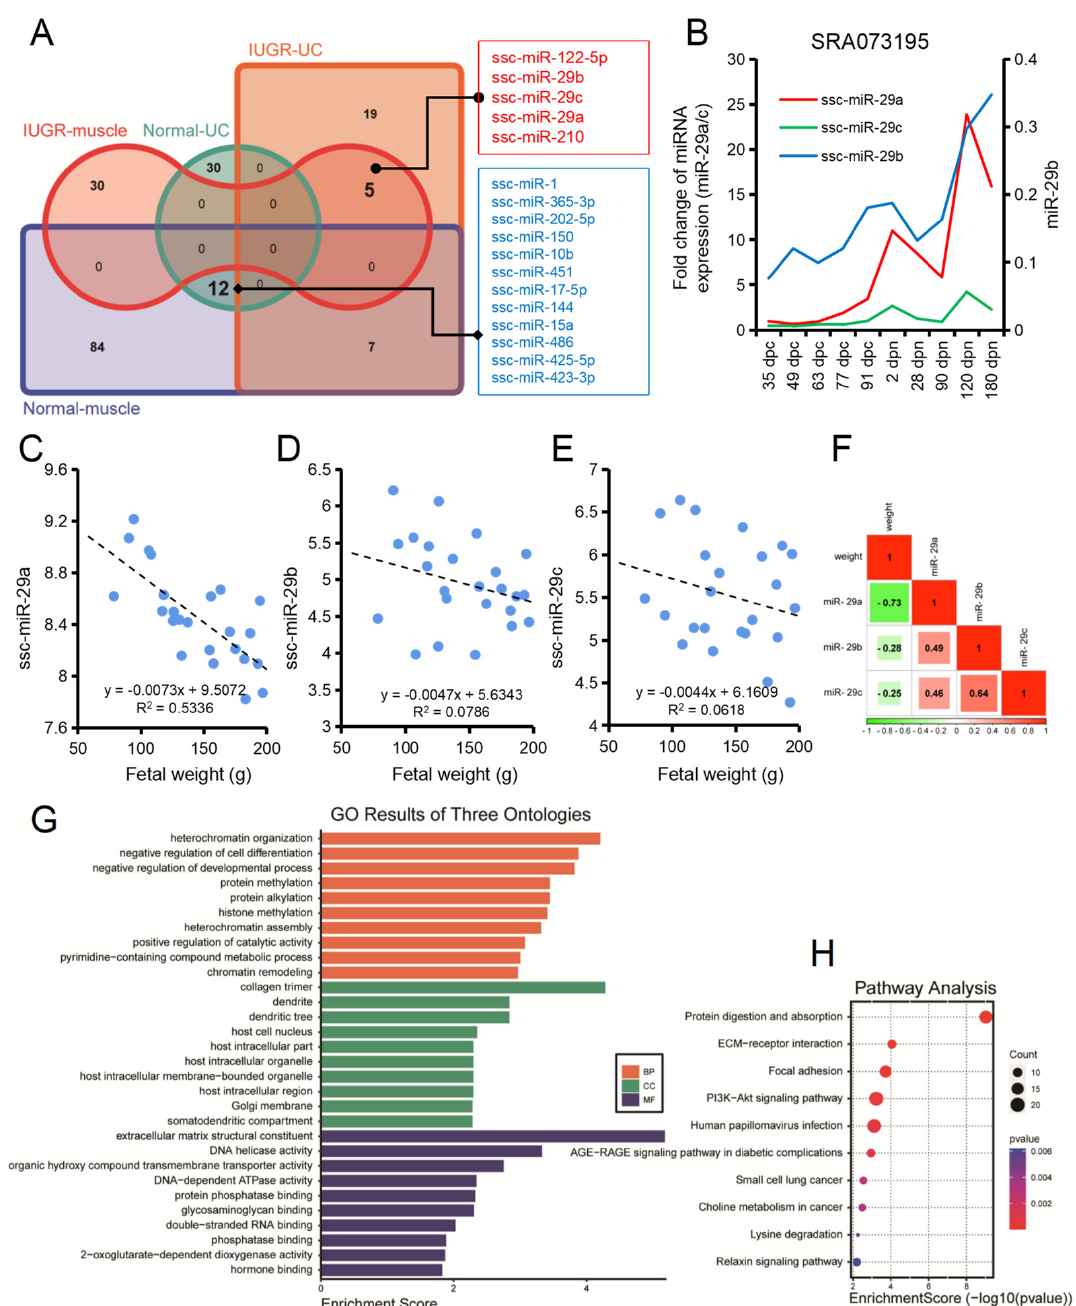
Figure 5. miR-29 family is central regulators of IUGR pig development. ( A ) Venn plots showing miRNA profiles in cord blood and skeletal muscle of normal and IUGR pigs; ( B ) Variation patterns of the miR-29 family during porcine skeletal muscle development; ( C – F ) Correlation analysis of relative expression levels of skeletal muscle miR-29 family with pig embryo weight; miR-29a ( C ), miR-29b ( D ), miR-29c ( E ), correlations among miRNAs within the miR-29 family ( F ). Data from GSE169093; ( G ) GO analysis results of common target genes of the miR-29 family; ( H ) KEGG analysis results of common target genes of the miR-29 family.